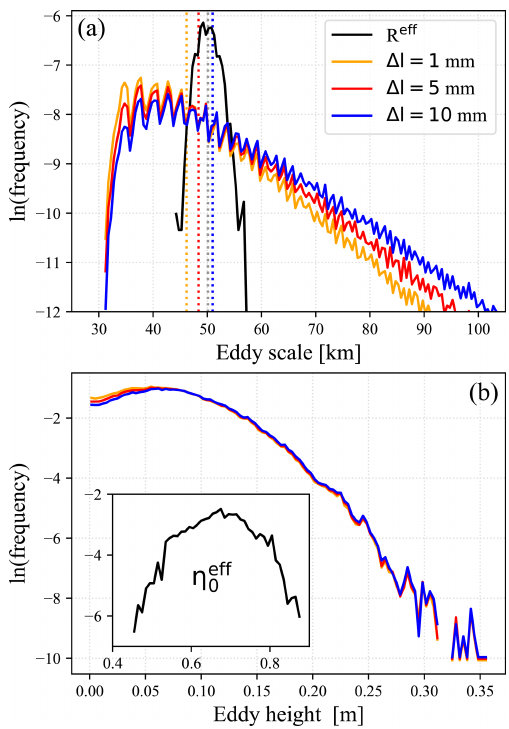
Figure 6. (a) Normalized eddy-scale distributions obtained by in- dividual eddy census with the closed contour SLA method (Chel- ton et al., 2011) at three different level spacing parameters (cid:49)l ; see legends. Vertical dotted lines indicate the mean values of the his- tograms. Black curve denotes the normalized histogram of R eff pa- rameter of the super-vortex. The logarithm of frequencies is scaled on the vertical scale. (b) Normalized eddy height distributions ob- tained by individual vortex census as in panel (a) . The inset shows the histogram for the height parameter of the super-vortex fit η eff meters. Both the eddy census and super-vortex fit were performed over the offshore region (westward from 125.0 ◦ W longitude; see Fig. 4).